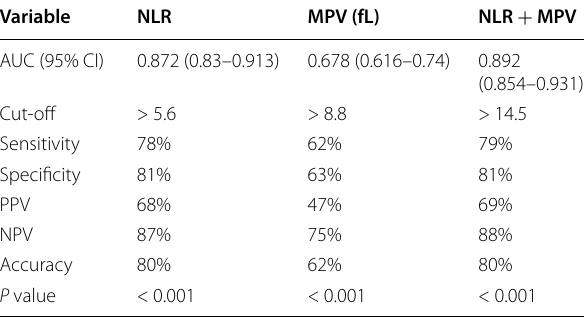
Table 3 ROC curve analysis of diagnostic accuracy of NLR, MPV, and combined NLR MPV to detect +